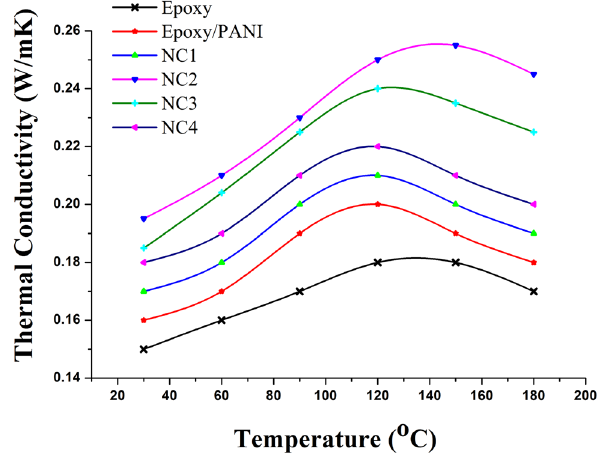
Figure 6: Schematic diagram of the conductive path inside the epoxy/PANI/GNPs ( NC2 ) nanocomposites. Figure 7: Thermal conductivity of epoxy, epoxy/PANI, and epoxy/ PANI/GNPs